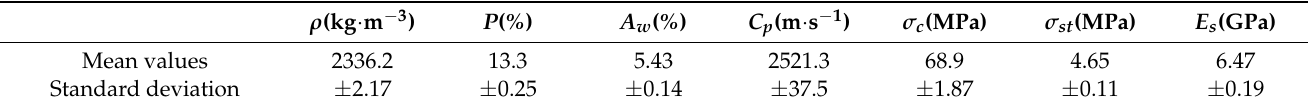
Table 2. Physical and mechanical properties of the sandstone (mean values and standard deviation).